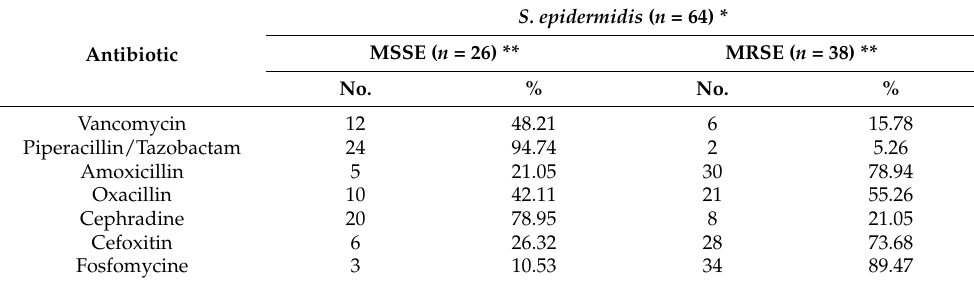
Table 2. The numbers and percentages of MSSE and MRSE for different antibiotics.